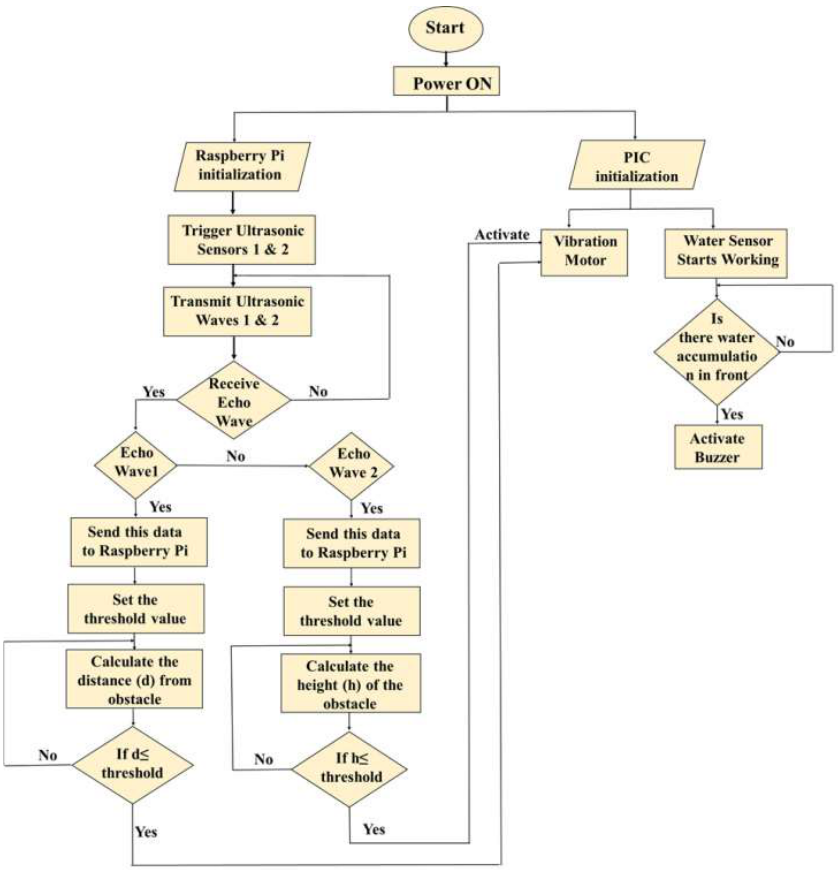
Figure 3. Flowchart of execution of obstacle detection.